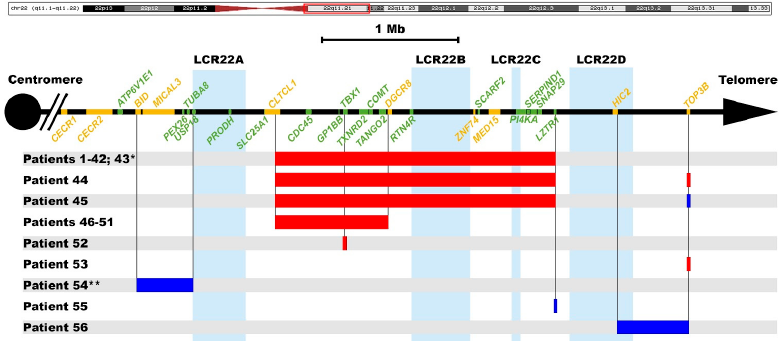
Figure 1. Microdeletions and microduplications in the 22q11 region among patients with CCHD. The red rectangle in the ideogram above displays the chromosome 22q11 region included in the analyses. Horizontal red bars indicate deletions, while the blue ones represent duplications. The OMIM genes are in green. Regions involving the different low copy repeats (LCRs) are highlighted in light blue. The imbalances extensions are delimited by vertical black lines. When only one probe from the MLPA kit is deleted or duplicated, only one vertical line is displayed. * This patient also presented a 9q34.3 duplication involving only one probe. ** This patient also presented a deletion involving at least 406 Kb in